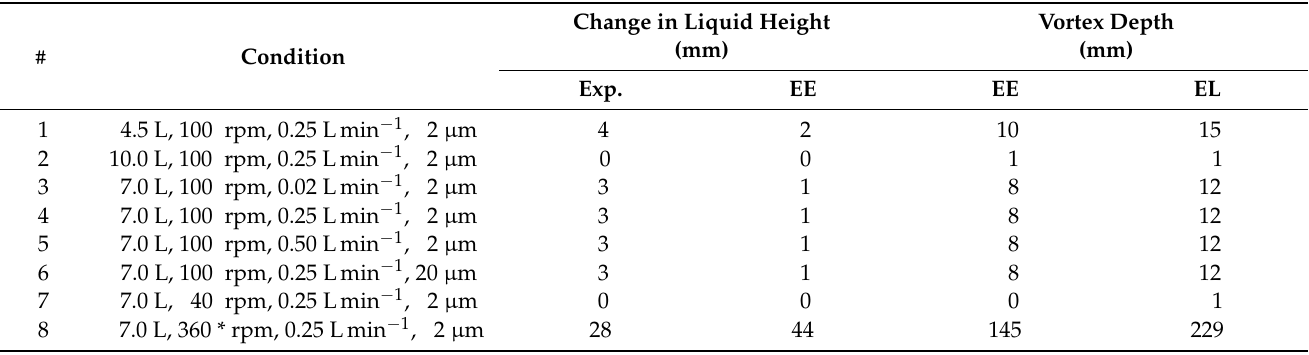
Figure 4. Surface vortex formation for 7.0 L, 350/360 rpm, 0.25 L min − 1 , 2 µ m, experiment without sparging. ( a ) Experiment, 350 rpm; ( b ) EL results, 360 rpm; ( c ) EE results, α l = 0.5, 360 rpm. Table 2. Change in liquid height and vortex depth found in experiments (exp.), in Euler–Lagrange (EL), and in Euler–Euler (EE)